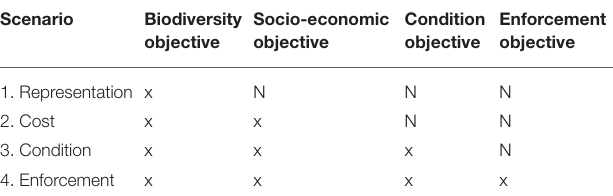
TABLE 5 | Four scenarios of networks of MPAs for the MPRC1 in Baja California, Mexico, based on single and multiple biophysical, and socio-economic objectives (x, objective included; N, objective not